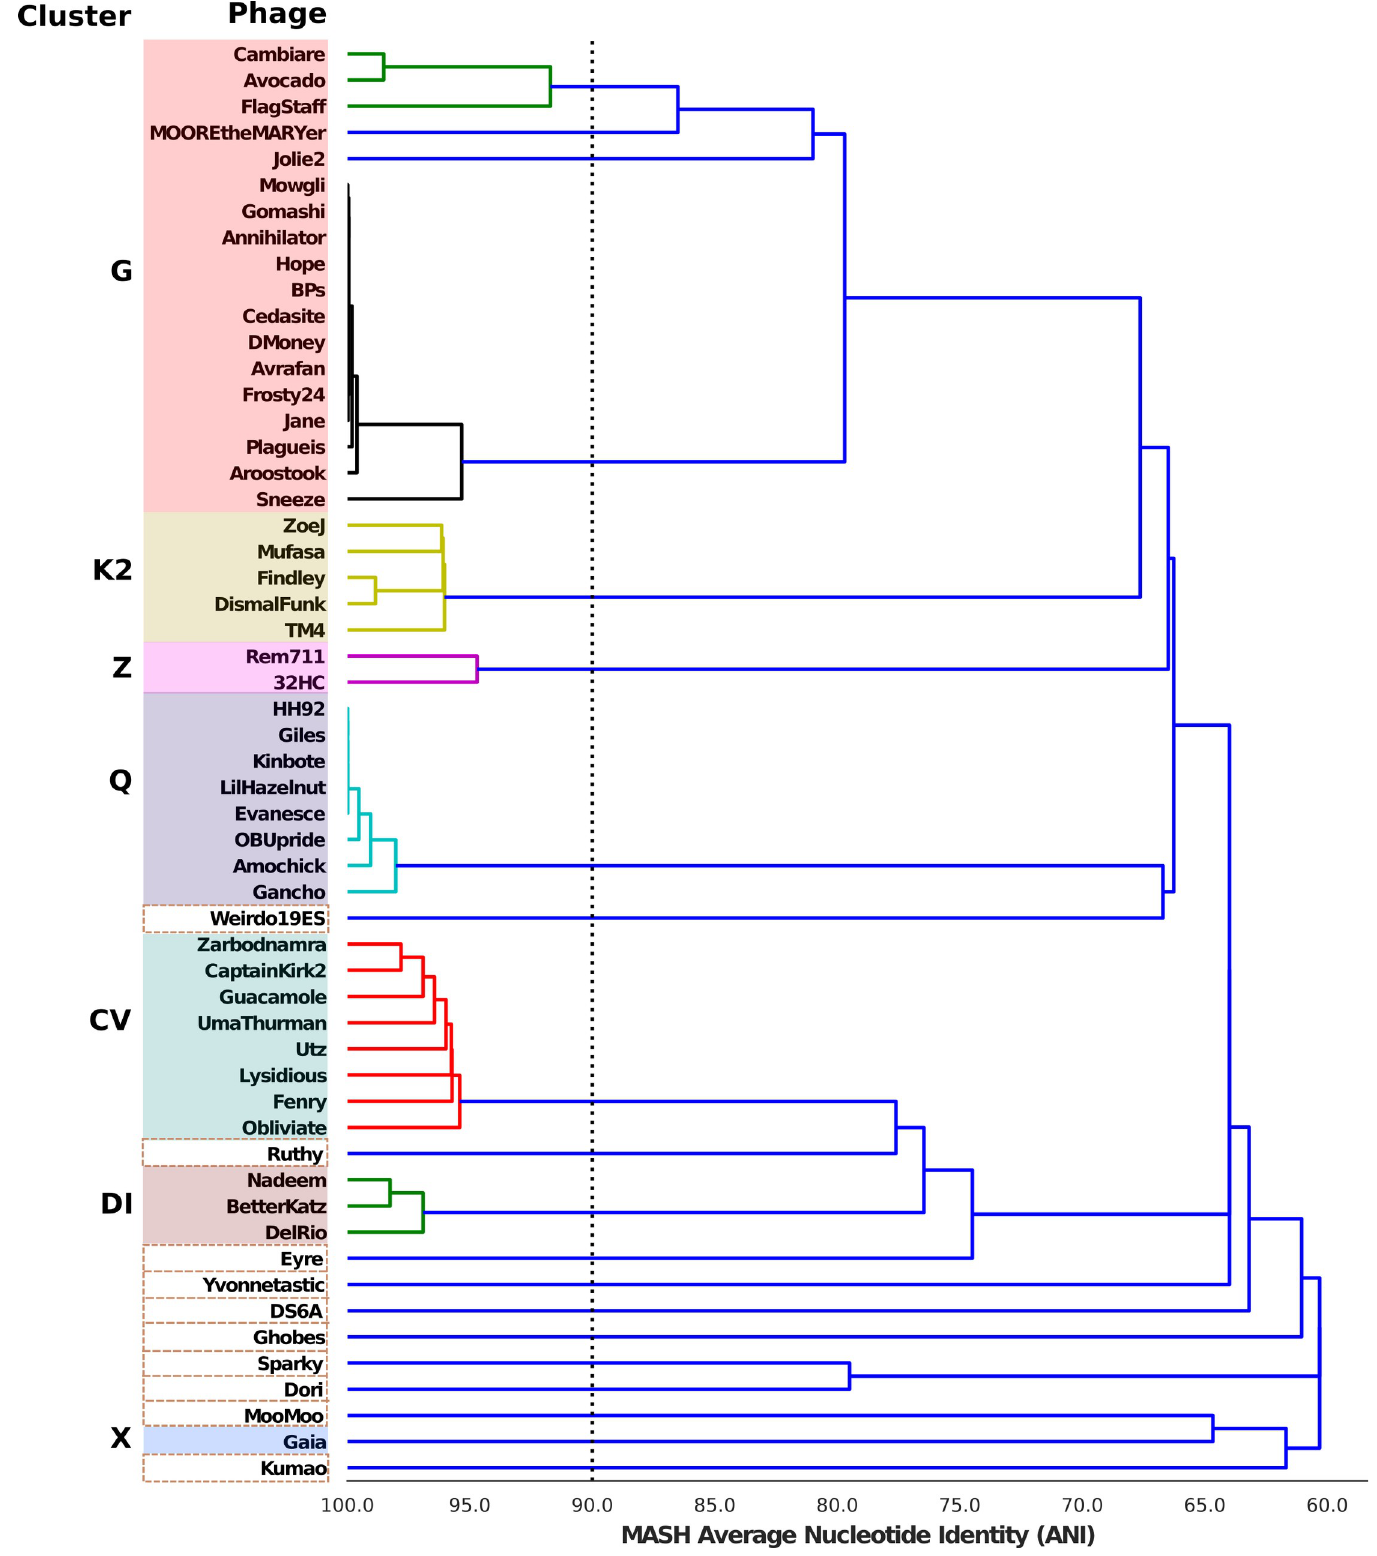
Fig 6. Mash distance dendrogram. Primary clustering was performed using the pair-wise Mash distance with a 90% of ANI (dotted line) in dRep program [22]. The different mycobacteriophages clusters were colored and singletons are shown in dotted boxes.